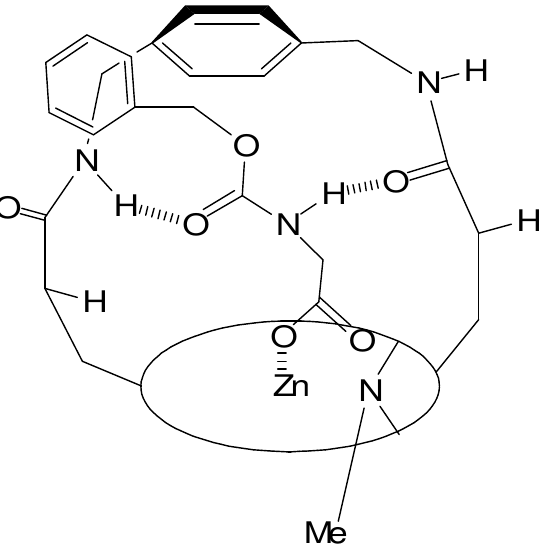
Figure 8. ( RS ),( R ) (right side) and ( RR ),( S ) substrate-receptor structures: the carboxylic Ru Ru function interacts with the Ru + -NH unit; CH interacts with π